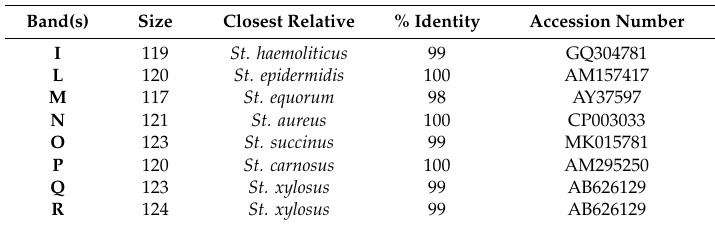
Table 1. Identification of the bands obtained by ePCR and PCR-DGGE analysis of the coagulase-negative catalase-positive cocci (CNCPC) bulk-collected samples (Figure 1).